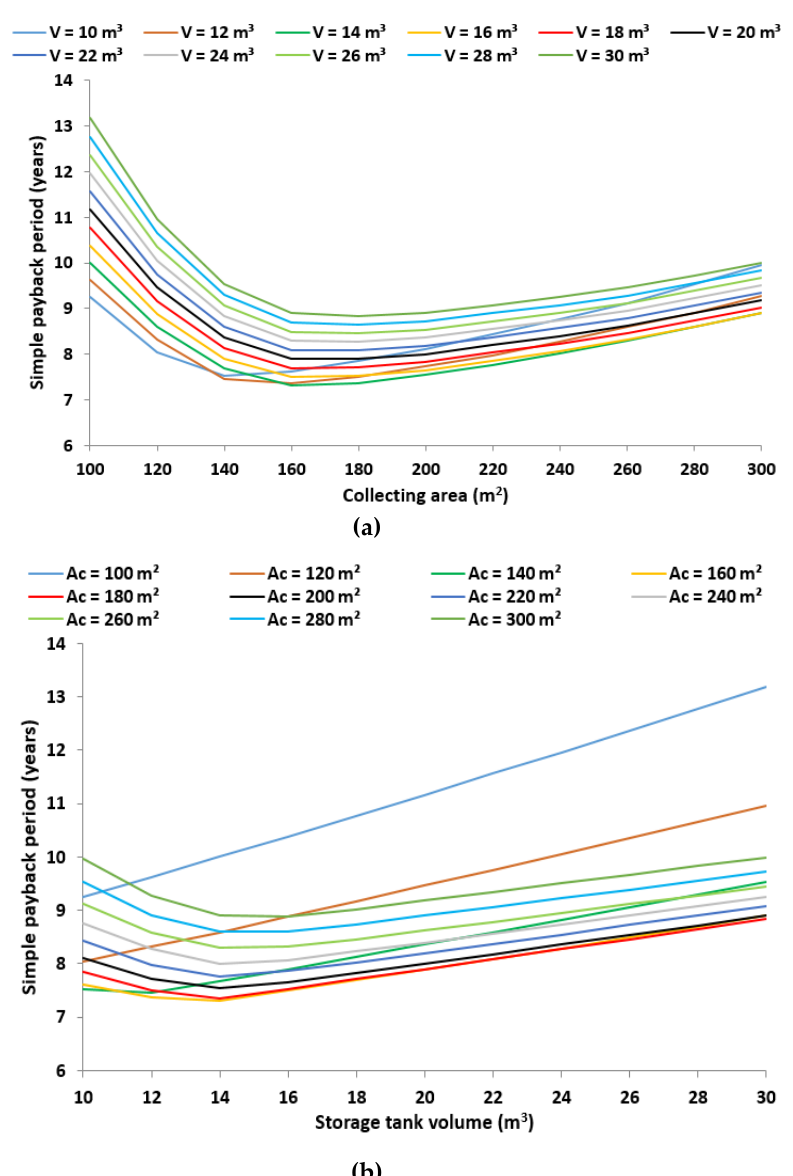
Figure 7. Simple payback period ( a ) for different collecting areas with the storage tank volume as the main parameter ( b ) for different storage tank volumes with the collecting area as the main parameter.